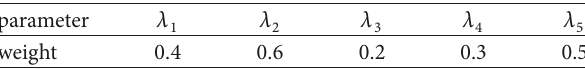
Table 6: The weight of the different factors when fusing the influ- ence.